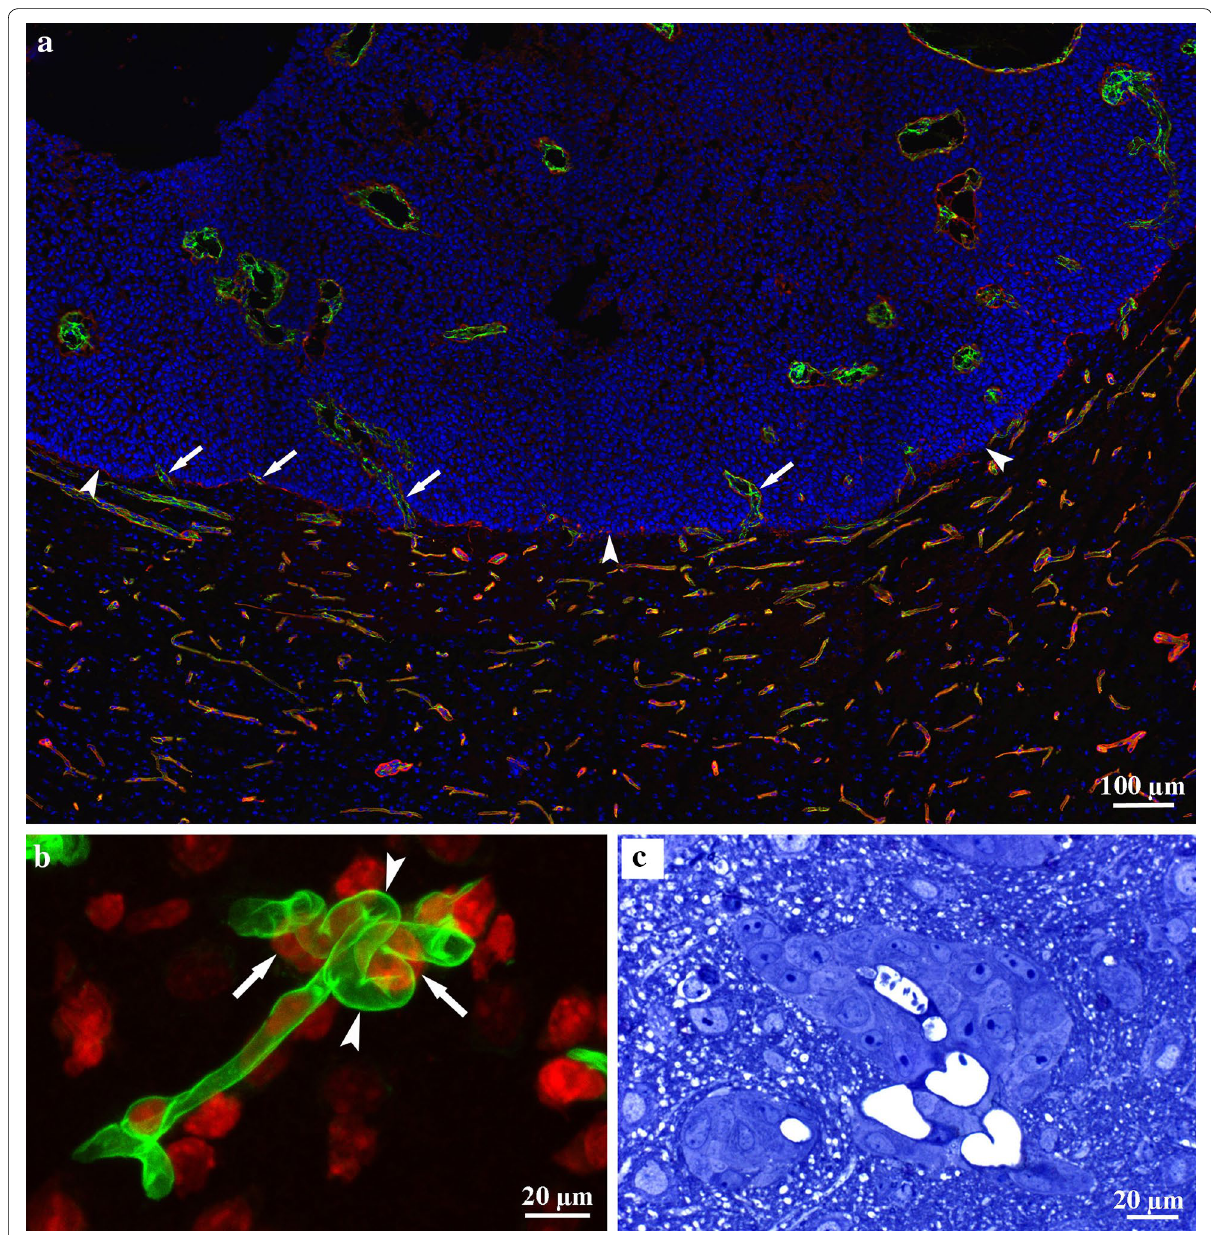
Fig. 1 Vessel incorporation and glomeruloid body formation in the brain. a Frozen section of an experimental brain metastasis of the C38 colo‑ rectal carcinoma cell line. The section is stained for CD31 (vessels, green ), laminin (basement membrane, red ), and 4 ′ ,6‑diamidino‑2‑phenylindole (DAPI; cell nuclei, blue ). The DAPI staining shows that the tumor is located in the upper part of the picture. Arrowheads show the tumorparenchyma interface. The tumor mass “flows” around the vessels, thereby incorporating them ( arrows ). Vessel density is significantly lower and vessel diameter is larger in the intratumoral region than in the peritumoral tissue. Scale bar 100 µm. b Glomeruloid body formation after injection of tumor cells into the carotid artery. Simple loops ( arrowheads ) of the capillary (laminin, green ) that develop in the vicinity of tumor cells ( arrows ) can be observed. Cell nuclei are stained by propidium iodide ( red ). Scale bar 20 µm. c Semi‑thin cross section stained by toluidine‑ blue represents a glomeruloid body formed in a colony of human melanoma cells. There are several capillary lumens within the small tumor cell group. Scale bar 20